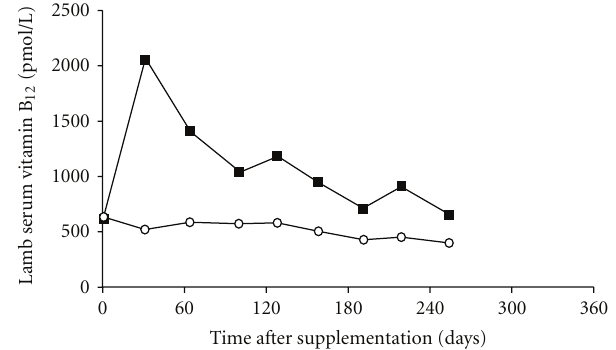
Figure 4: E ff ect of no treatment ( (cid:2) ) or subcutaneous injection of 3mg microencapsulated vitamin B 12 (about 0.20 mg/kg LW) ( (cid:3) ) administered to Co-adequate lambs at docking time on serum vitamin B 12 concentrations [23].